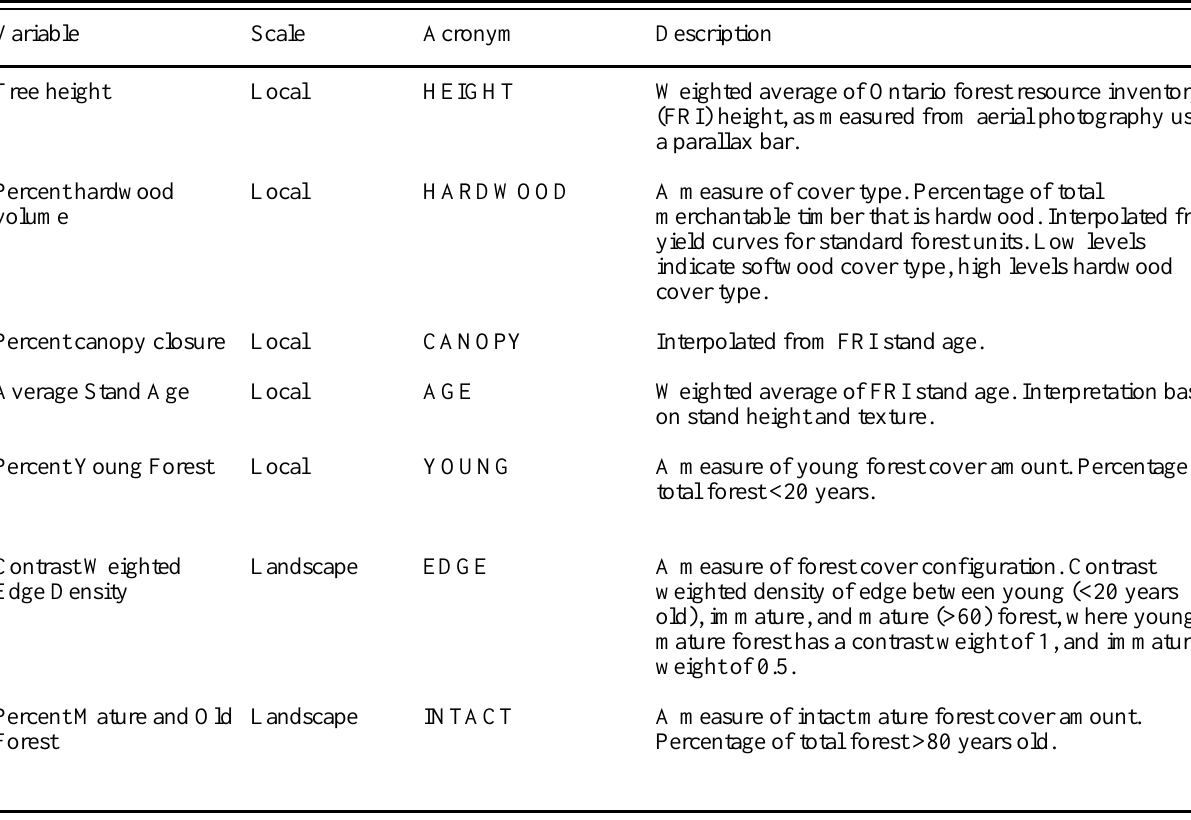
Table 1. Description of variables (and keywords) used in the habitat models. All variables calculated using hexagonal analysis units generated in LSL.